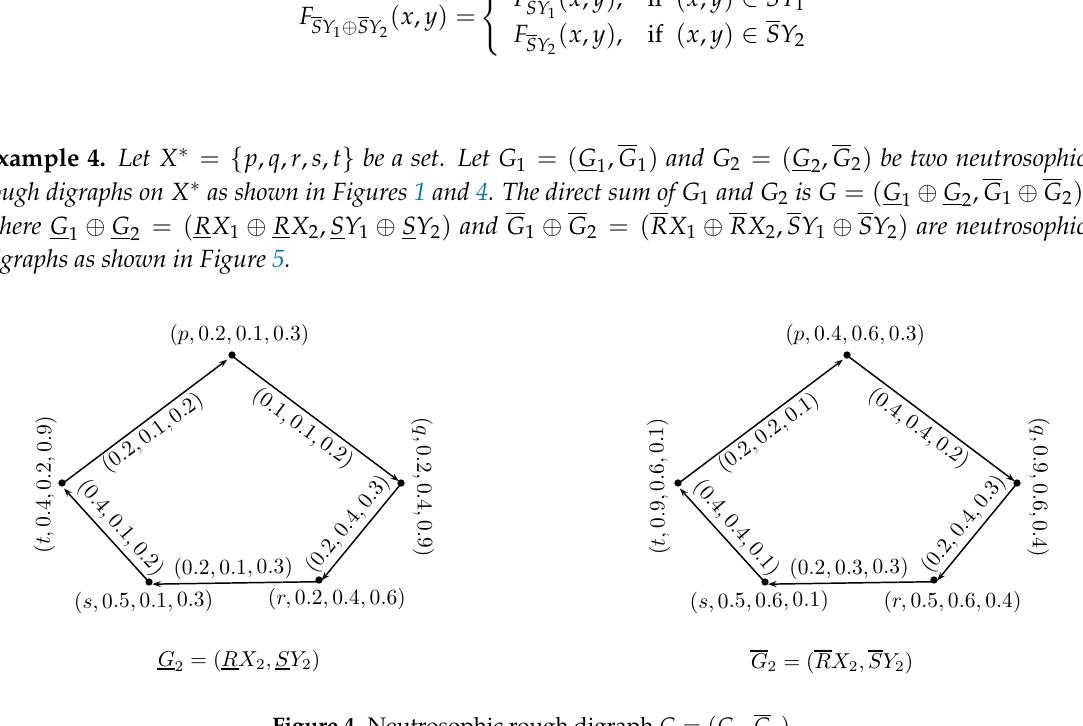
) Figure 4. Neutrosophic rough digraph G = ( G 2 , G 2 ) , G 2 2